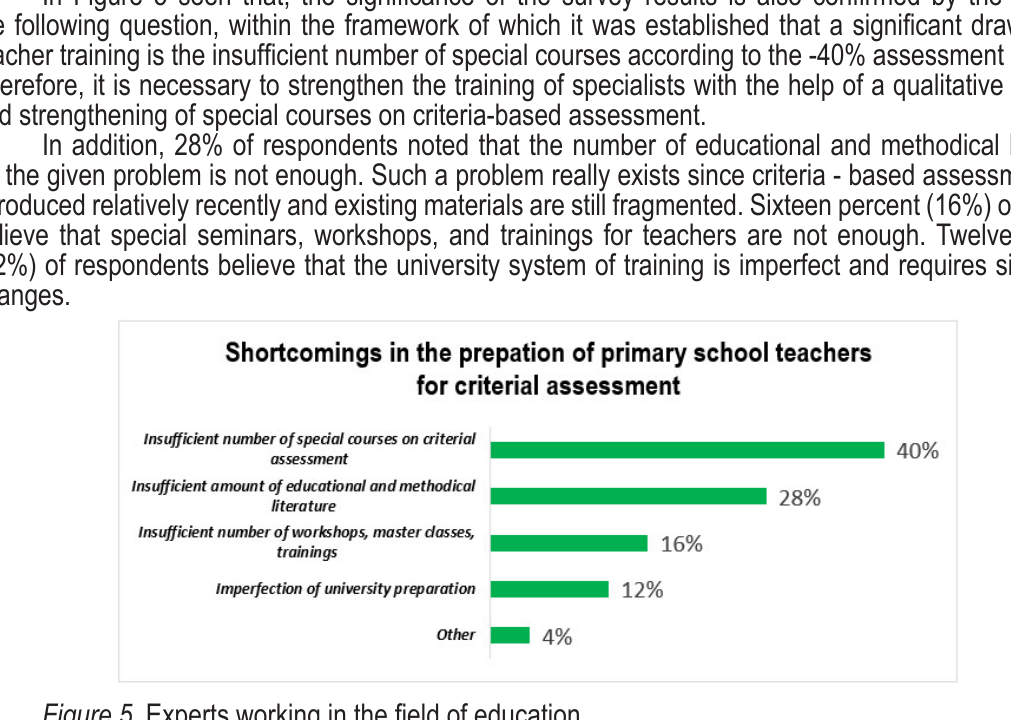
Figure 5. Experts working in the field of